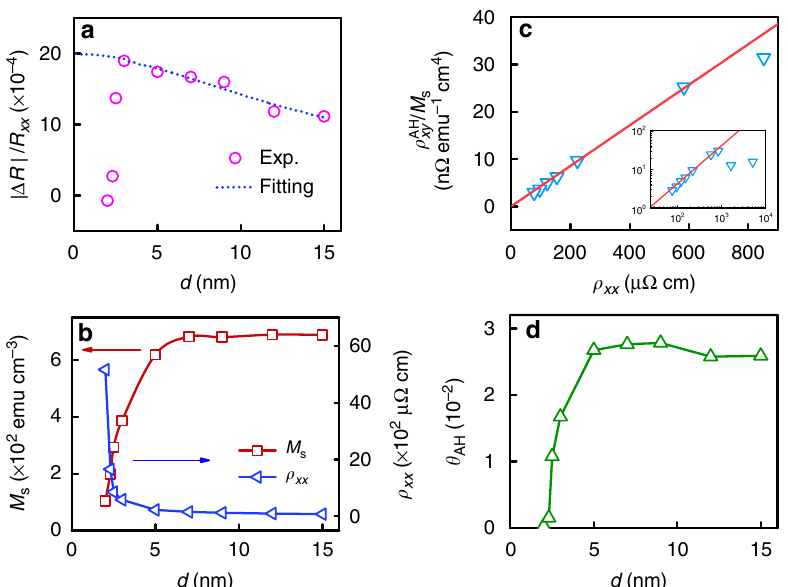
Fig. 5 Thickness dependence of AHMR and AHE in co-sputtered (Fe 0.71 Mn 0.29 ) 0.6 Pt 0.4 samples. a AHMR ratio for (Fe 0.71 Mn 0.29 ) 0.6 Pt 0.4 with d = 2 – 15 nm, and the fi tting using Eq. (4) with fi xed θ AH for d = 5 – 15 nm (dotted line). b Thickness dependence of M s and ρ xx . c ρ AH xy = M range. d Thickness dependence of θ AH . Inset of c shows the full range of ρ AH xy = M